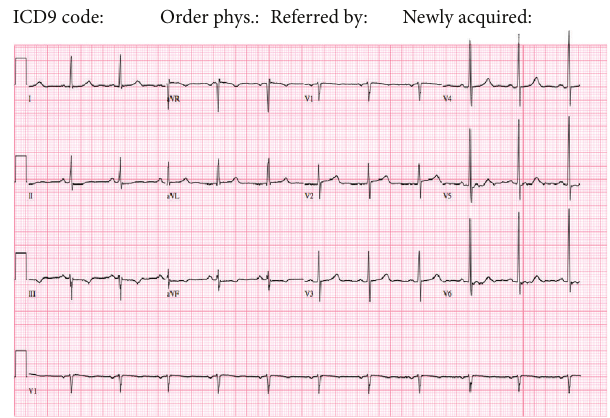
Figure 1: Admission EKG showing normal sinus rhythm (NSR) with T wave flattening and inversion in the inferior leads.